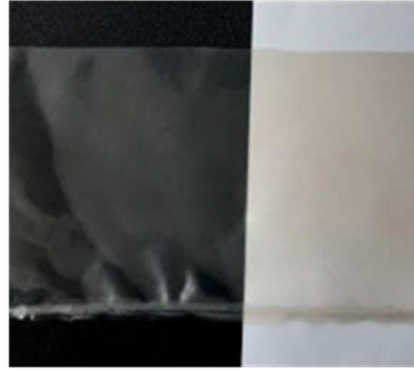
Figure 2. Pectin film